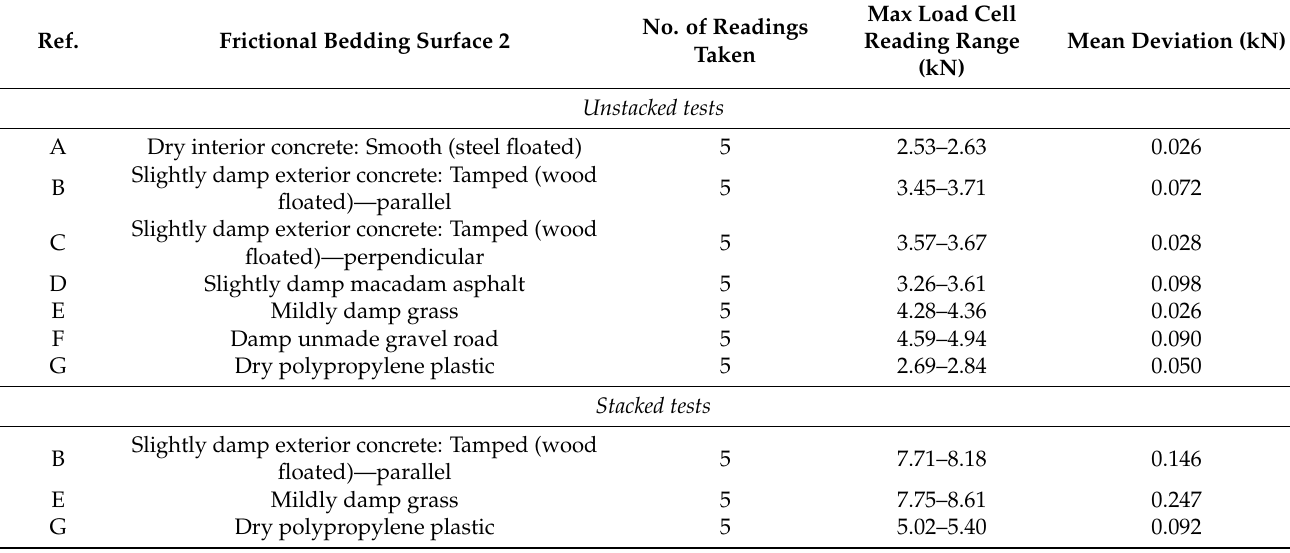
Table 4. Summary of raw data—unstacked and stacked